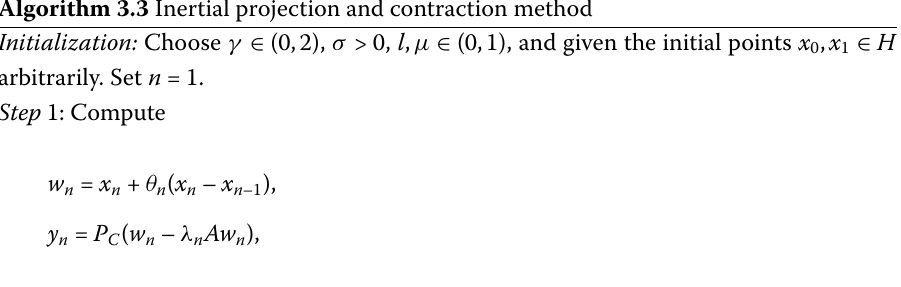
Algorithm 3.3 Inertial projection and contraction